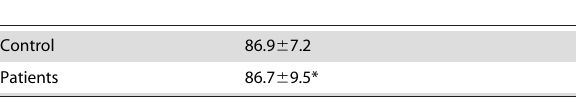
Table 2. Serum concentrations of CGRP (pg/mL).